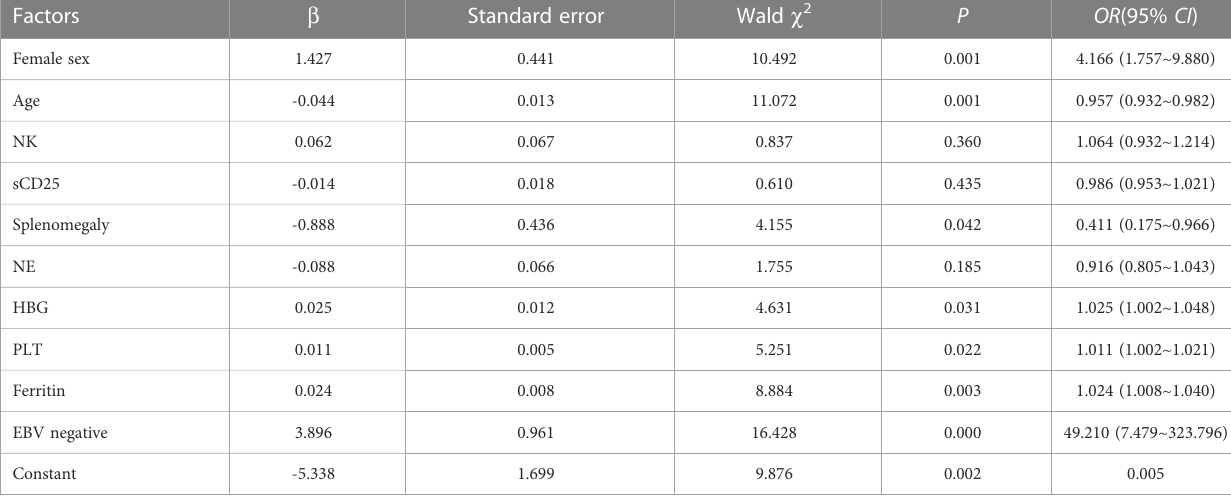
TABLE 4 Multivariate Logisticlogistic analysis for distinguishing patients with rheumatic and haematological disease-related HLH. Factors